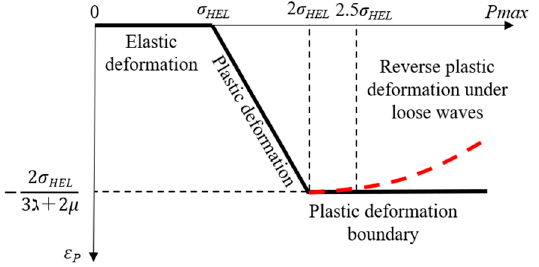
Figure 4. Relationship between the peak pressure and specimen deformation.